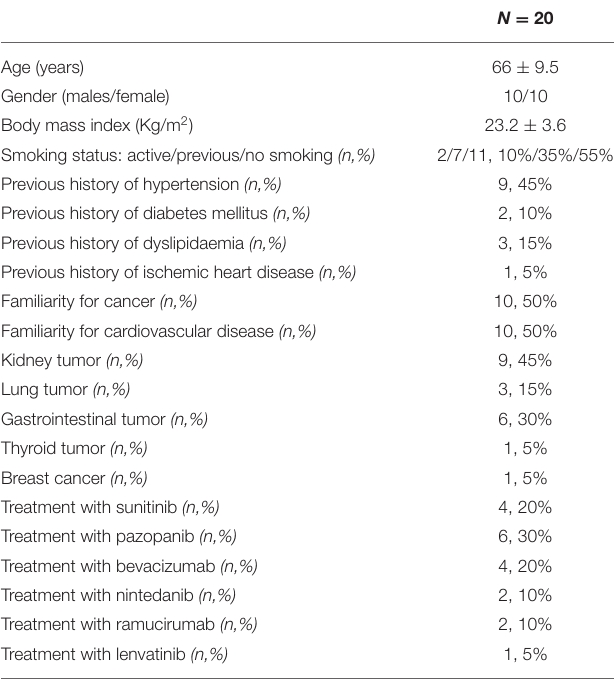
TABLE 1 | Demographic and clinical characteristics of the patients